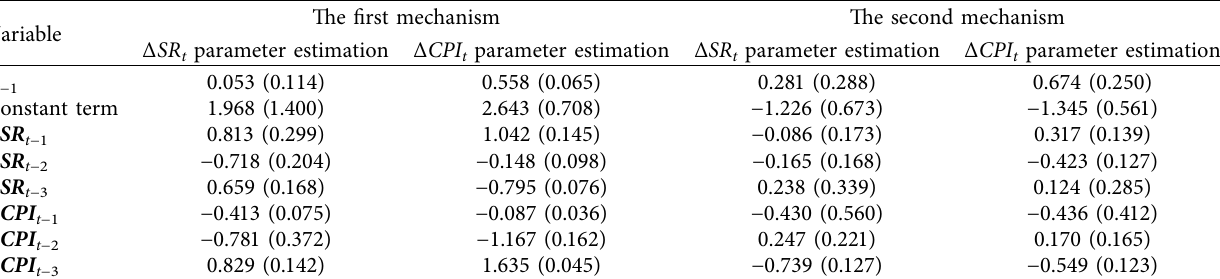
Table 7: Estimation results of model